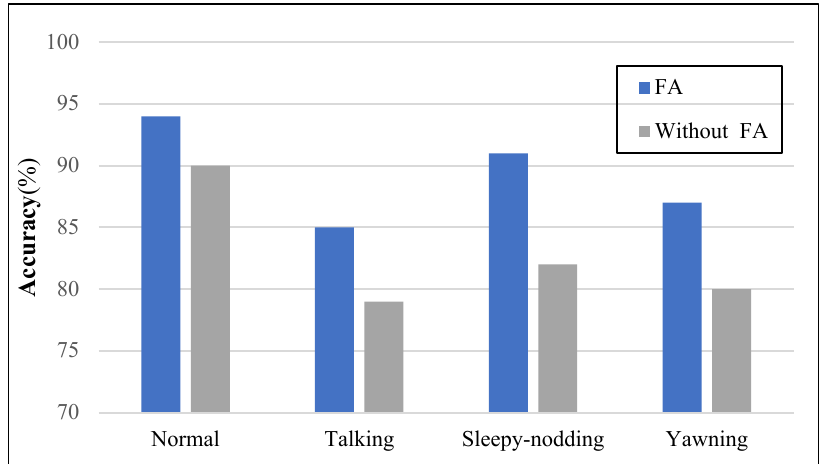
Figure 11. Comparison of the accuracy of each behavior detection with or without frame aggregation strategy on the FDF dataset. Table 3. Comparison results of the proposed method and state-of-the-art